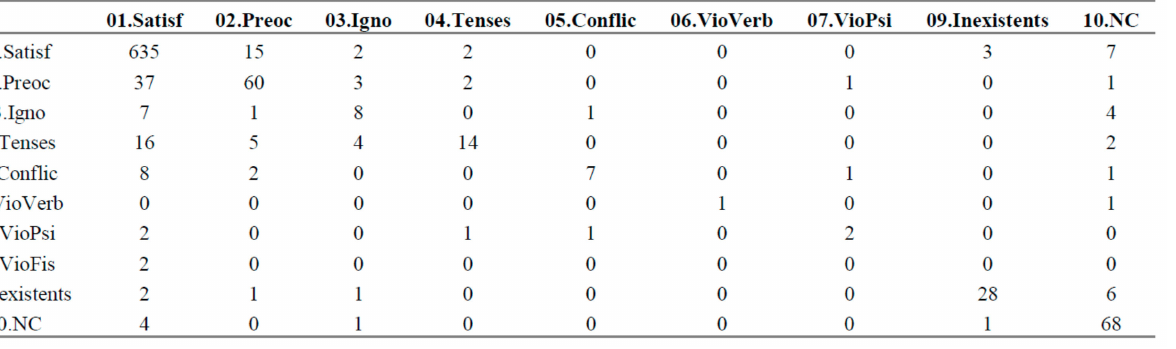
Figure 34. Expected changes July 2020–January 2021.